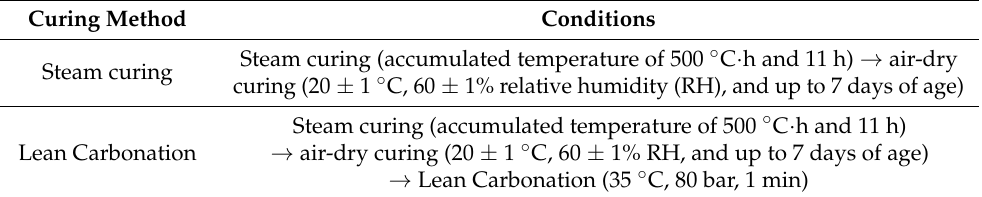
Table 8. Specimen curing conditions.